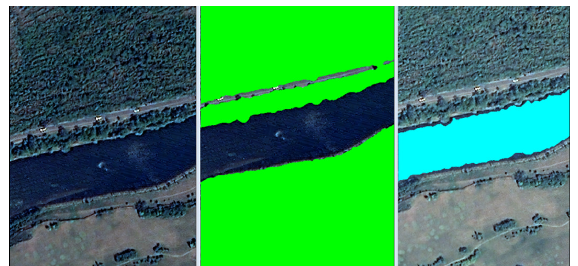
Figure 6. Vector layers of recognized vegetation and water objects